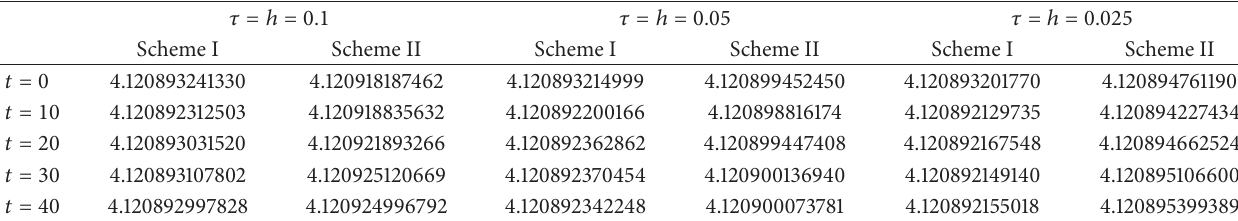
Table 5: When 𝛼 = 1 , numerical simulations on the conservation invariant 𝑄 𝑛 .